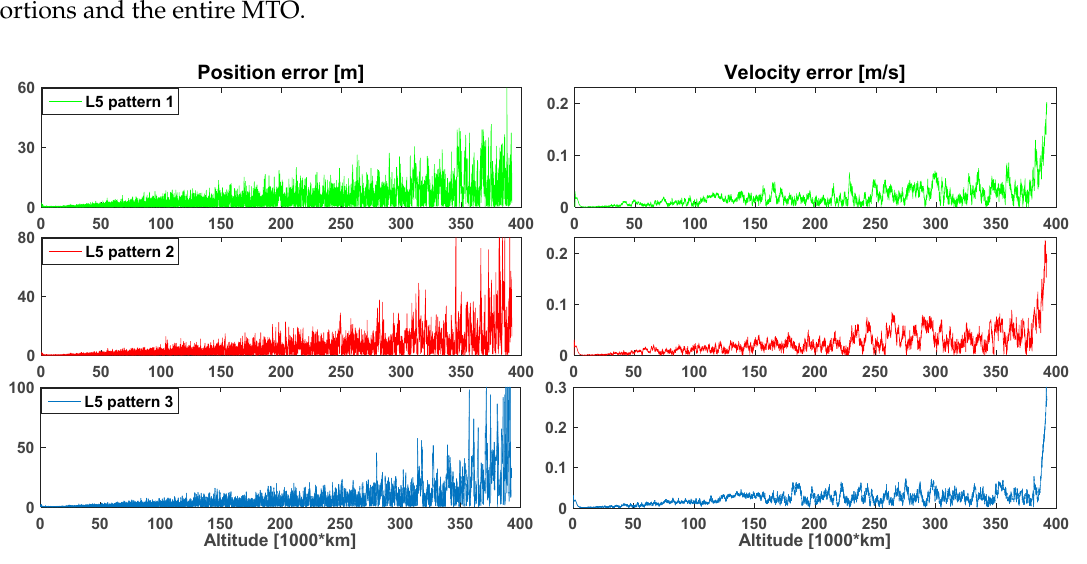
Table 7. Statistics of the single-point least squares estimation error.